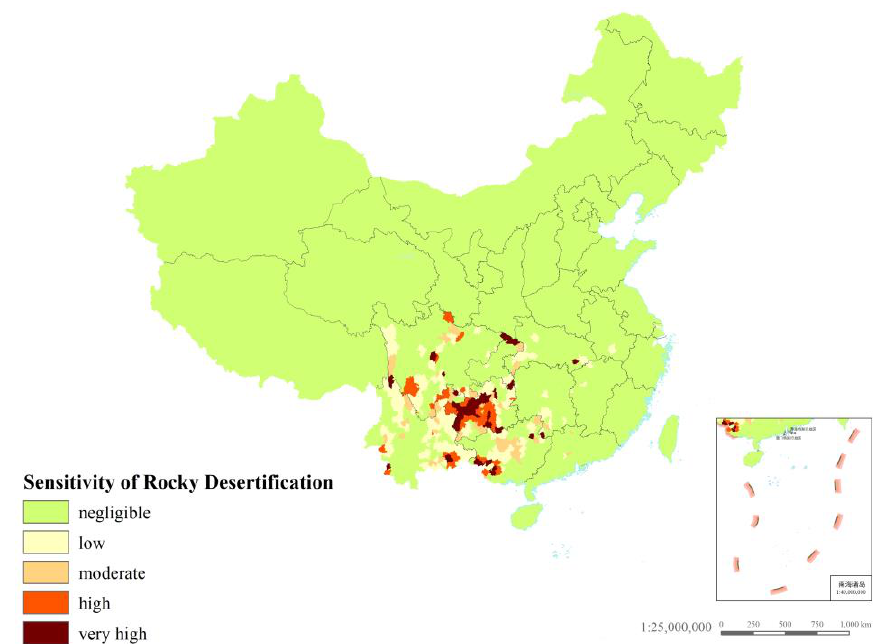
Figure 5. The County-based Rocky Desertification Sensitivity Index in China.